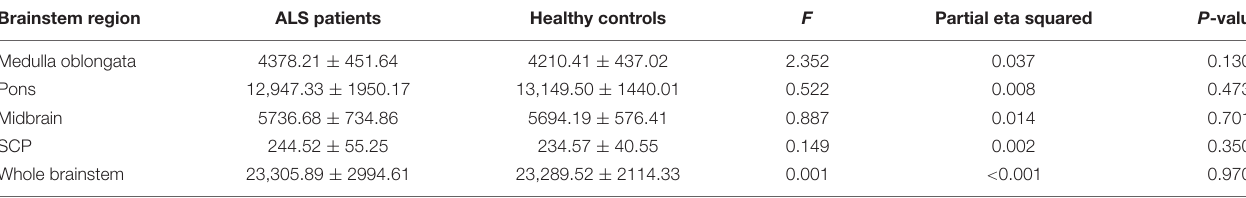
TABLE 2 | Difference of volumes of brainstem regions between the ALS and healthy controls group. Brainstem region ALS patients Healthy controls